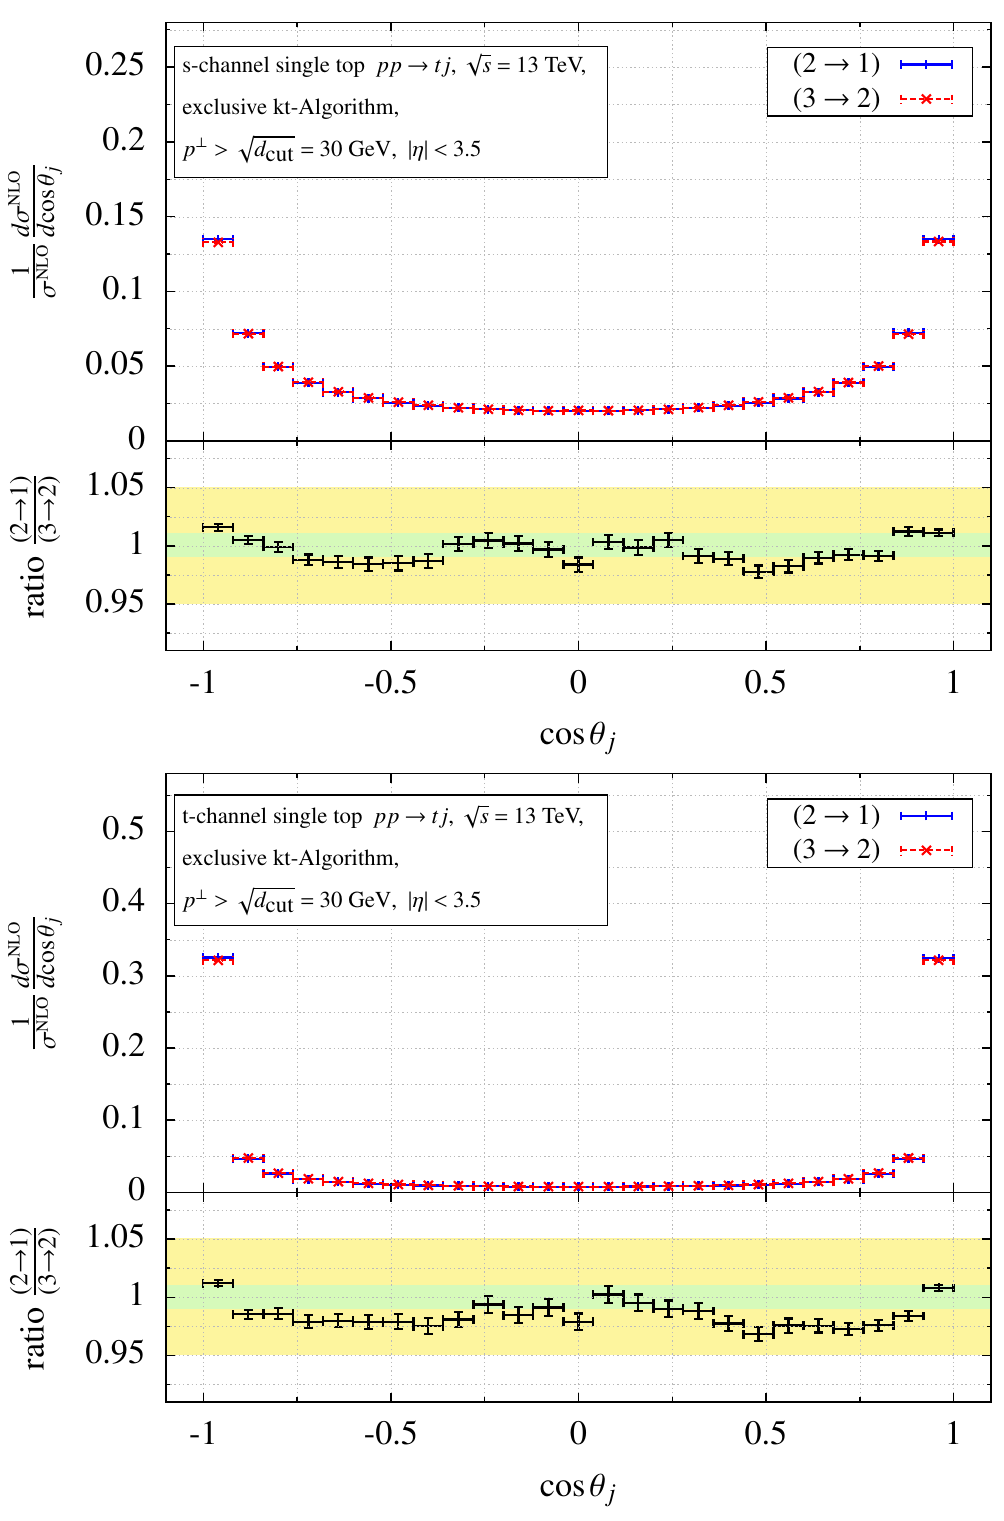
Figure 26 . Polar angle distributions for the light jet from s - and t -channel single top-quark production at NLO with 3 ! 2 (red, dashed) and 2 ! 1 (blue, solid) jet clusterings.